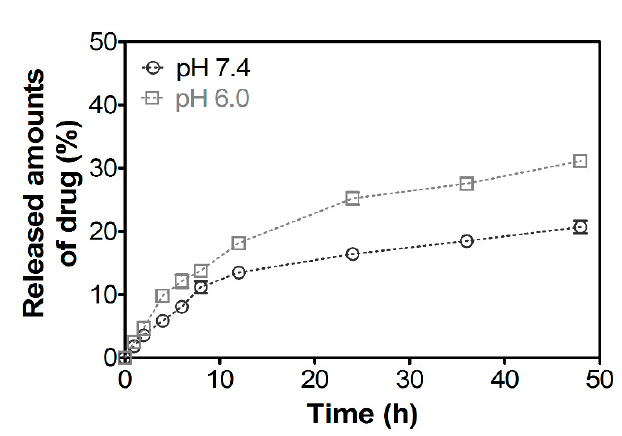
Figure 5. In vitro release profiles of docetaxel from CHS-CS NPs at pH 6.0 and 7.4. Each point represents mean ± S.D. ( n = 3).